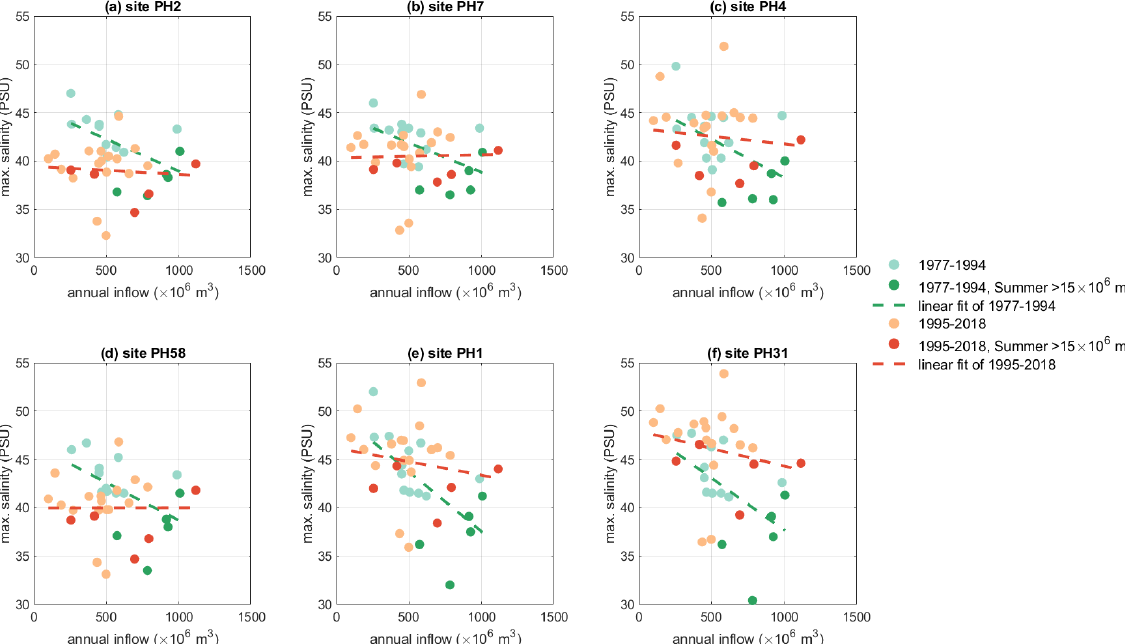
Figure 11. Maximum salinity recorded in March/April and the annual inflow in the hydrologic year (March to March) at six monitoring sites (see the site locations in Fig. 1). The darker symbols indicate the years with accidental summer rainfall events, during which the catchment inflows were higher than 15 × 10 6 m 3